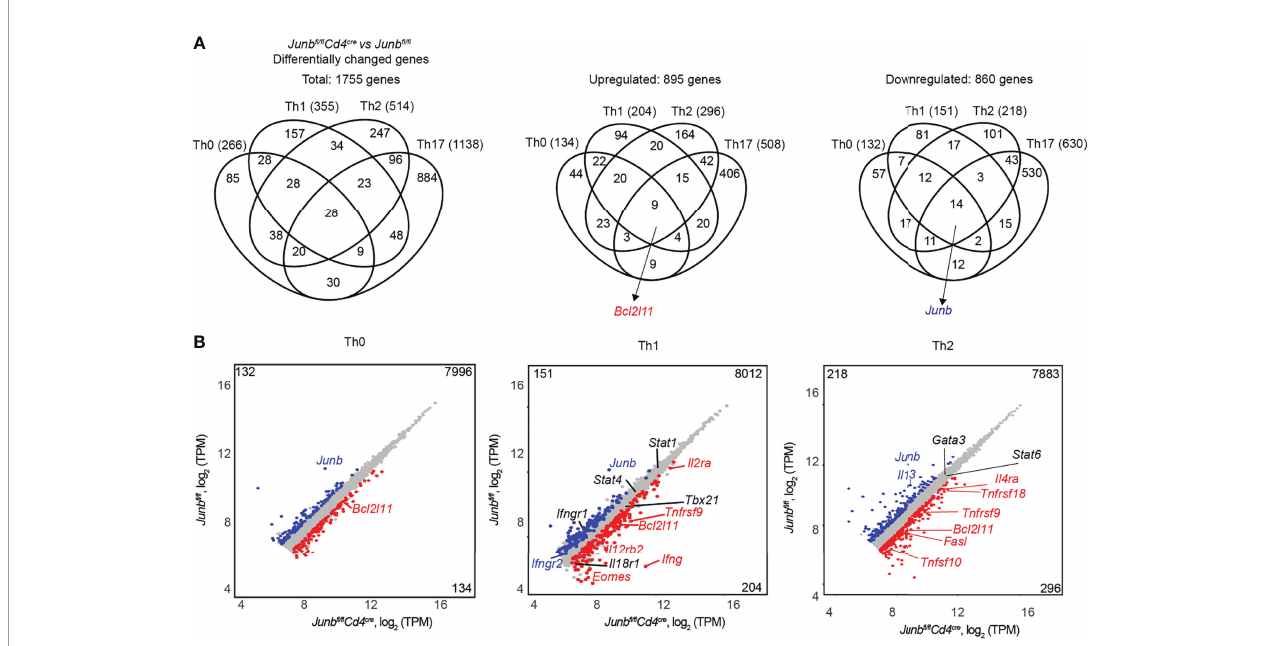
FIGURE 6 | JunB-dependent transcriptional regulation in T helper cell differentiation. Naive CD4 + T cells isolated from Junb fl / fl or Junb fl / fl Cd4 Cre mice were cultured under Th0-, Th1- and Th2-polarizing conditions for 48 h and subjected to RNA-seq analysis. Differentially expressed genes in Junb -de fi cient CD4 + T cells vs control cells (log 2 fold change > 0.5 or < -0.5, p value < 0.05, base mean > 100 TPM (normalized transcript per kilobase million)) were identi fi ed in each Th-polarizing condition. (A) Venn diagrams show the overlap of differentially expressed genes identi fi ed in Junb -de fi cient CD4 + T cells vs control cells under different Th-polarizing conditions. RNA-seq data for Junb -de fi cient CD4 + T cells and control cells cultured under Th17-polarizing conditions were from GSE 98414. (B) Scatter plots represent genes differentially expressed in Junb -de fi cient CD4 + T cells vs control cells under differentiation conditions for Th0, Th1, and Th2 cells. Genes considered signi fi cantly upregulated or downregulated are highlighted in red and blue, respectively. Genes with insigni fi cant changes are highlighted in grey. On each plot, left top and right bottom numbers indicate numbers of upregulated or downregulated genes,